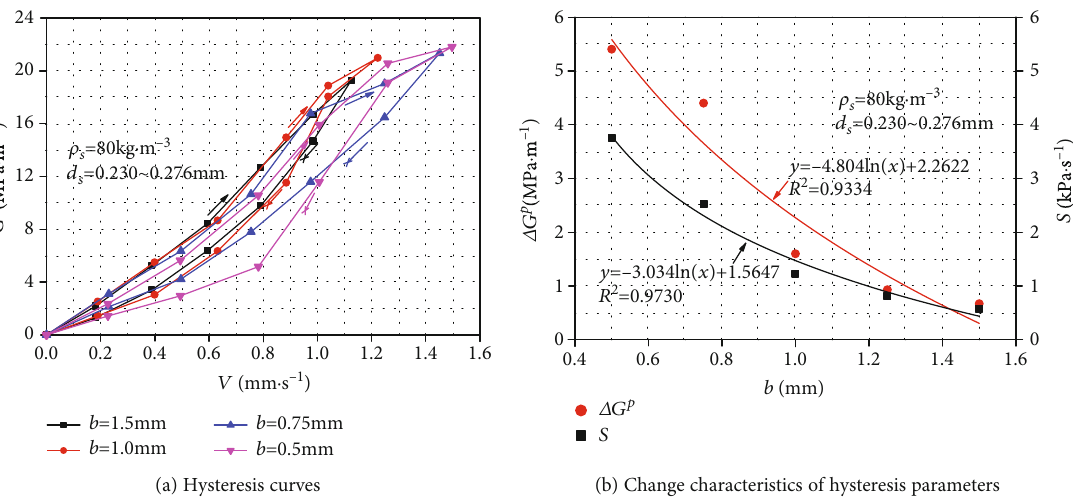
Figure 13: Water-sediment mixture seepage hysteresis characteristics under the in fl uence of fracture